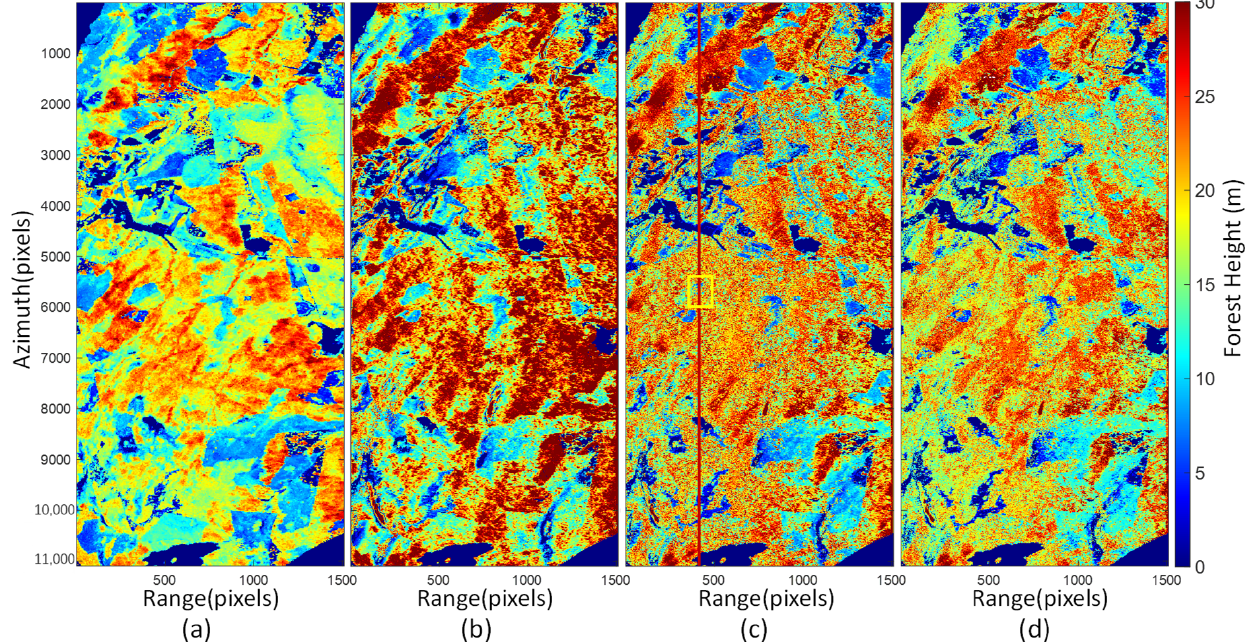
Figure 10. PolInSAR forest height retrieval results for boreal forest at Krycklan. ( a ) LiDAR forest height product, ( b ) dual-baseline PolInSAR forest height inversion results based on the RVoG model, and ( c ) dual-baseline PolInSAR forest height inversion results based on the PCT model; ( d ) dual-baseline PolInSAR forest height obtained by correcting the height of canopy scattering peak.